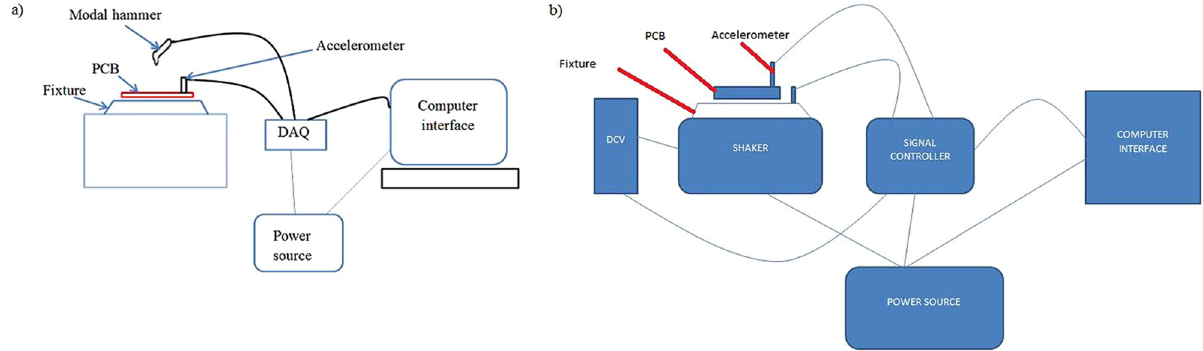
Fig. 8. Block diagram of the experimental setup. (a) Modal analysis. (b)